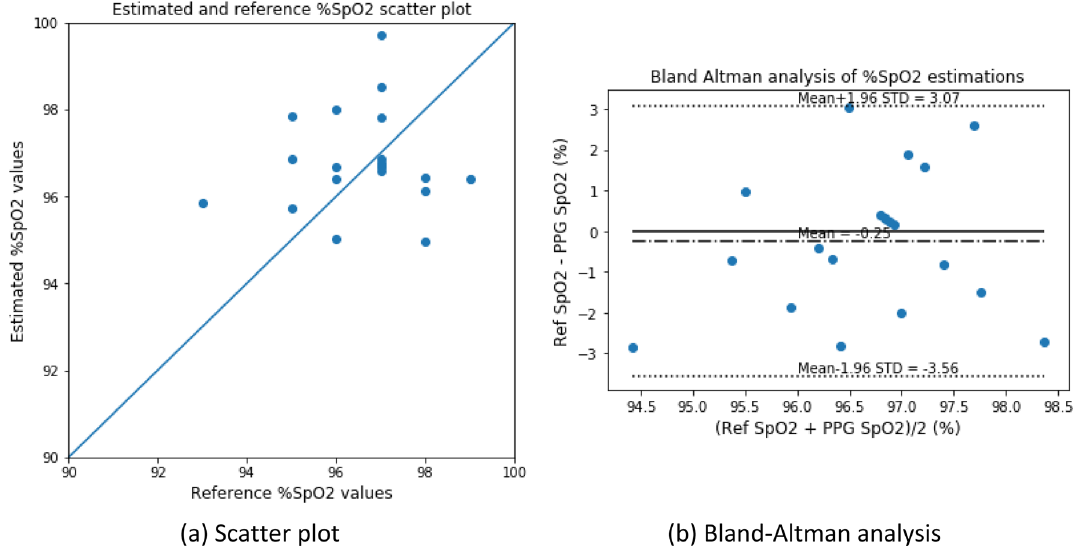
Figure 14. Scatter plot and Bland–Altman analysis of the estimated versus reference (measured) %SpO 2 values for the whole-finger model.